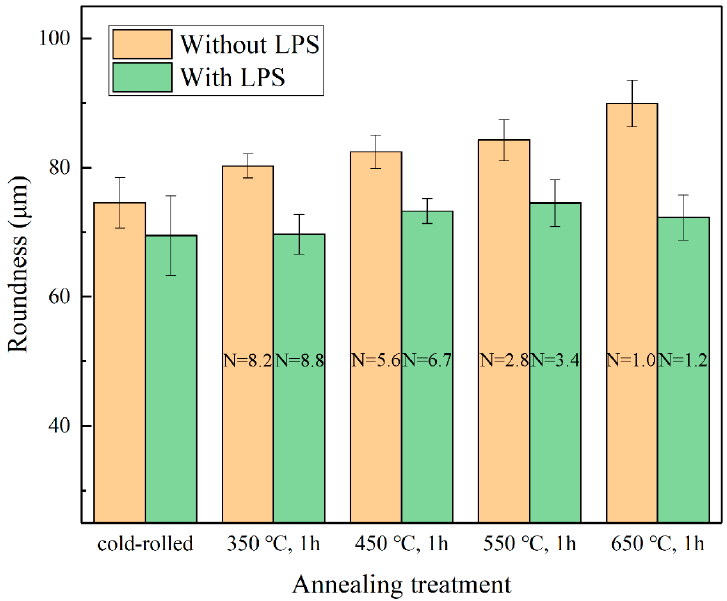
Figure 20. Influence of initial grain size on the shape accuracy of punched holes with and without LPS under a laser energy density of 38.2 J/cm 2